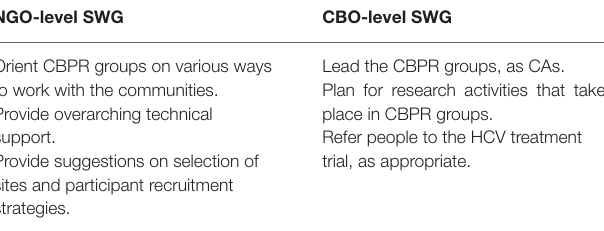
TABLE 3 | Roles of SWGs: NGO-level and CBO-level. NGO-level